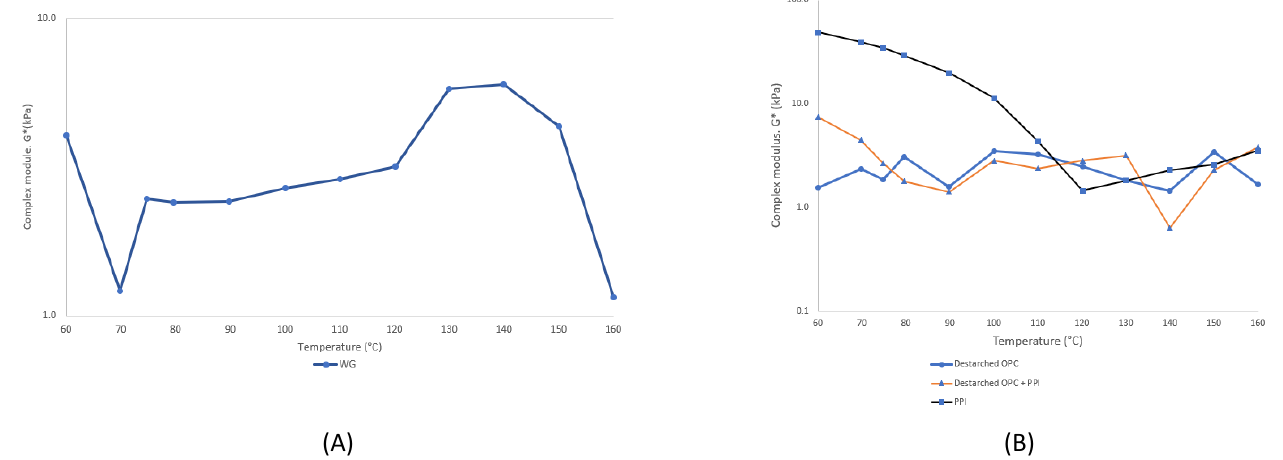
Figure 2. (a) The temperature sweep of wheat gluten (WG).; (b) The temperature sweep of pea protein isolate (PPI) (control sample), destarched oat protein Figure 2. ( A ) The temperature sweep of wheat gluten (WG); ( B ) the temperature sweep of pea protein isolate (PPI) (control concentrate (OPC), and destarched oat protein concentrate (OPC) + pea protein isolate (PPI). The temperature range was from 60 to 160 ° C, strain and frequency sample), destarched oat protein concentrate (OPC), and destarched oat protein concentrate + pea protein isolate. The were kept constant (1.5% and 1 Hz, respectively). temperature range was 60 to 160 ◦ C and strain and frequency were kept constant (1.5% and 1 Hz,